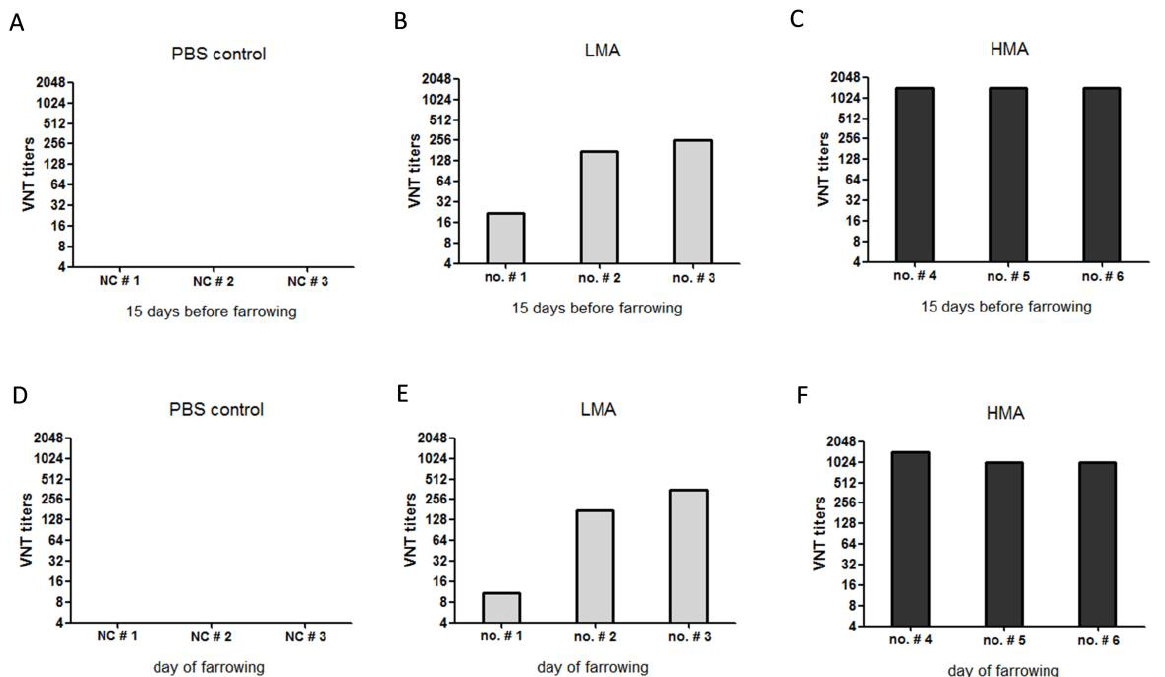
Figure 2. Detection of anti-SVA antibodies in sows after vaccination with SVA vaccines. The serum samples of the sows in the PBS control group, the LMA group, and the HMA group were collected 15 days before farrowing ( A – C ) and on the day of farrowing ( D – F ) respectively; the antibody titers were assessed by VNT analysis.